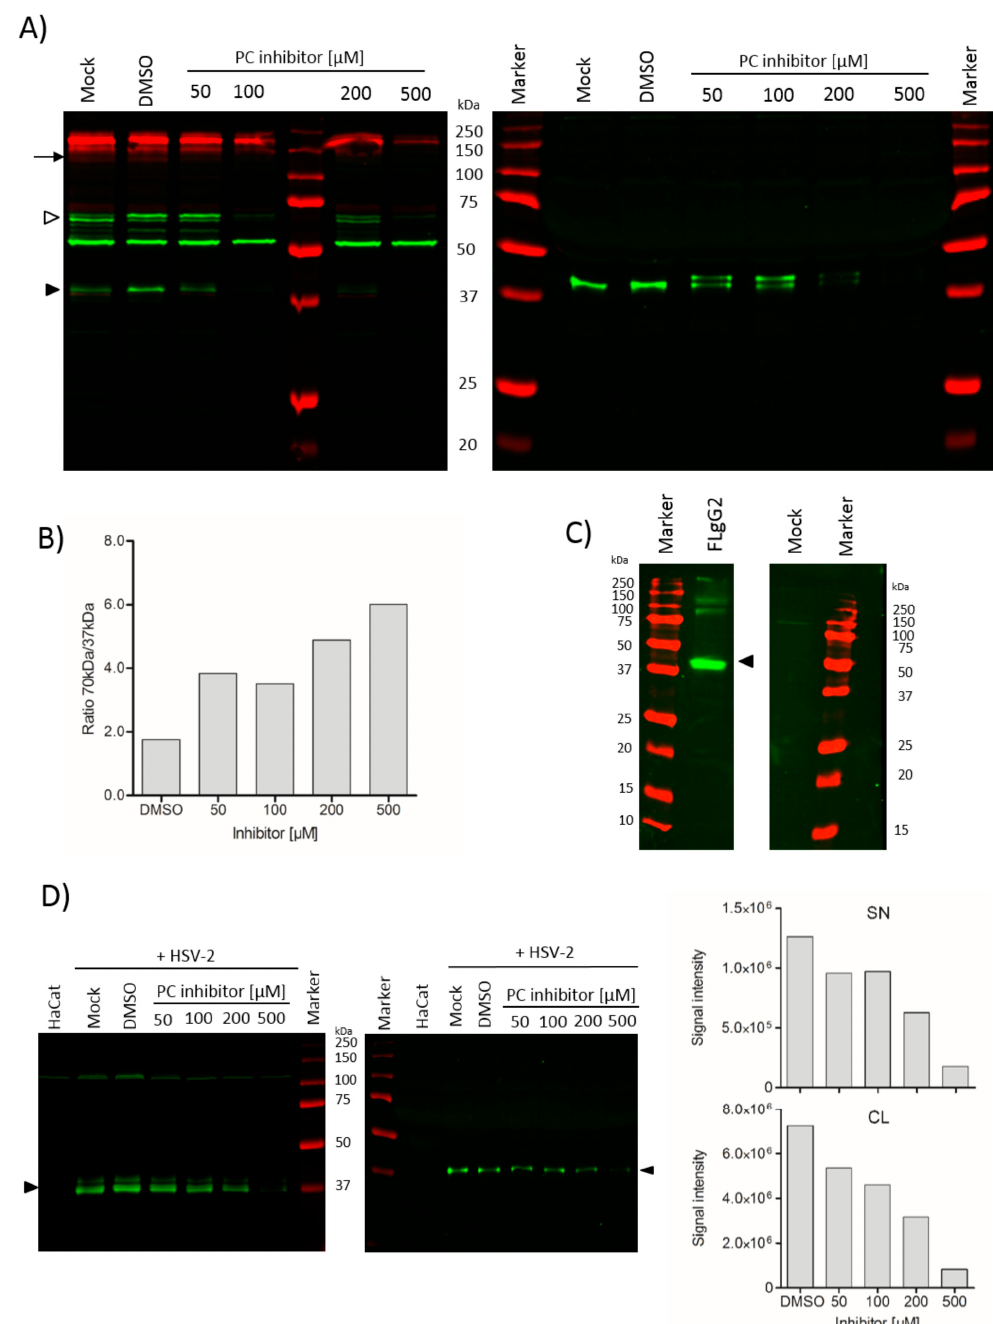
Figure 8. Members of furin-like host proteases are necessary for SgG2 processing. ( A ) Western blots showing detection of gG2 proteins in the cell lysate (CL, left blot) and supernatant (SN, right blot) of HEK-293T cells transfected with SgG2 and treated with increasing doses of Furin Inhibitor I (Decanoyl-RVKR-CMK, Calbiochem) for 24 h post transfection. An HIV envelope gp160 expression plasmid was used as a control and detected with an anti-gp120 antibody (red). The SgG2 proteins were detected with anti-V5 (green) antibody. Black arrowhead indicates SgG2 cleavage products, and white arrowhead indicates precursor protein. The arrow points to HIV envelope gp120 protein. One of two independent experiments is shown. ( B ) Ratio of 70 kDa precursor protein (white arrowhead) and 37 kDa SgG2 cleavage product (black arrowhead) calculated from quantification of bands in cell lysate blot in panel ( A ). ( C ) Western blot showing detection of FLgG2 protein in the cell lysate of LoVo cells, deficient in furin activity. The proteins were detected with anti-V5 (green) antibody. Black arrowhead indicates SgG2 cleavage product. One of two independent experiments is shown. ( D ) Western blot